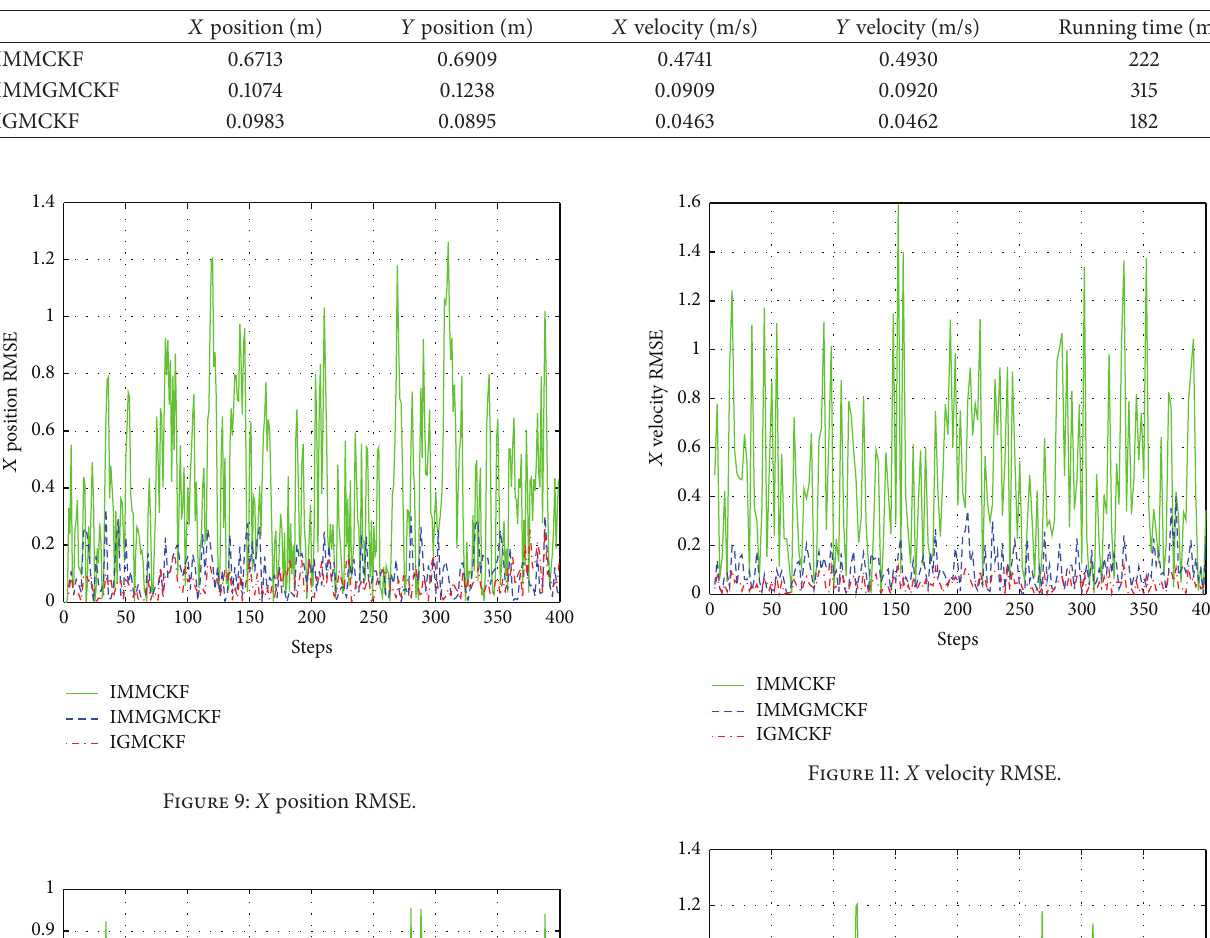
Table 3: Comparisons of average RMSE and running time of different algorithms.